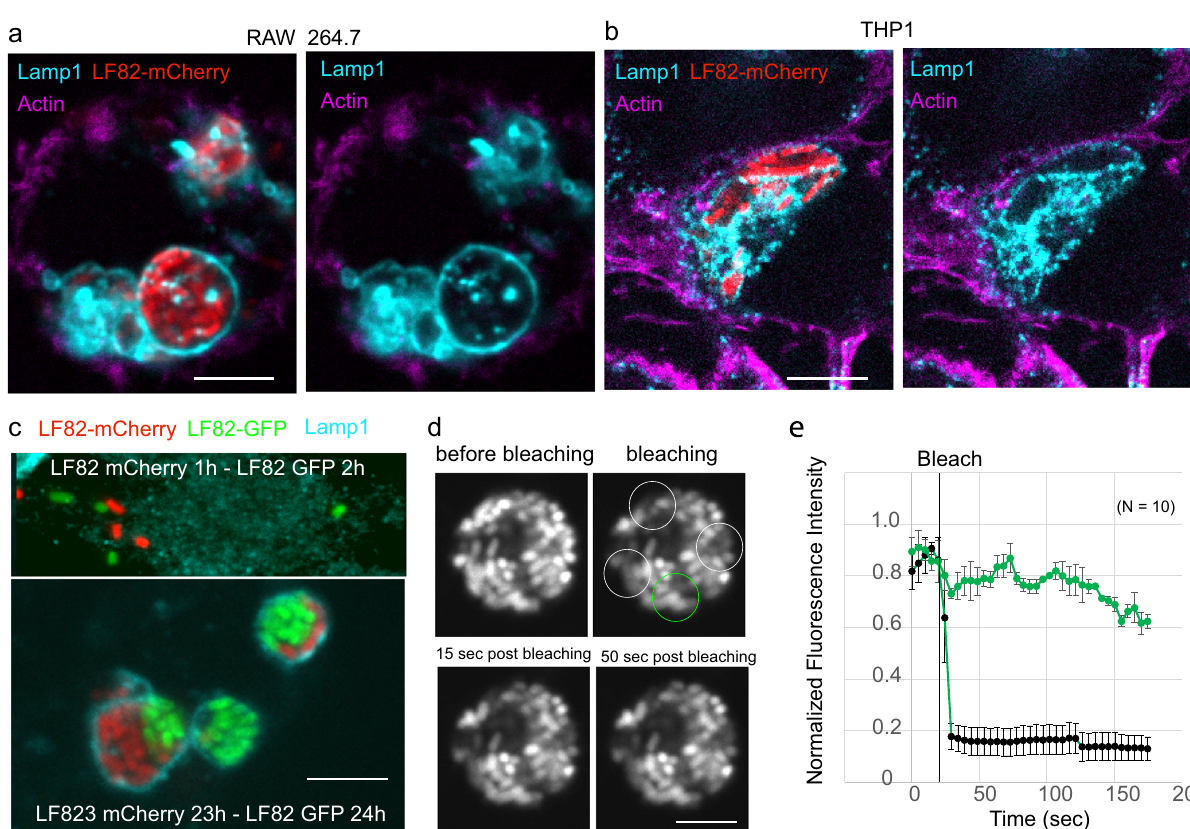
Fig. 1 Intracellular LF82 form intracellular bacterial communities inside phagolysosomes. a Imaging of the phagolysosomes (antibody for Lamp1, cyan) of Raw macrophages (actin labeling with phalloidin, magenta) infected by LF82-mCherry (red) at an MOI of 30 at 24 h of P.I. b ) Imaging of the phagolysosomes of THP1 macrophages infected by LF82-mCherry at an MOI of 30 at 24 h of P.I. c Coinfection experiment. Raw macrophages were infected fi rst with LF82-mCherry, treated with gentamycin for 1 h to remove free LF82-mCherry and subsequently infected with LF82-GFP. At 24 h of P.I., phagolysosomes were labeled with the Lamp1 antibody (cyan) and imaged. d FRAP experiments on phagolysosomes containing LF82-GFP at 24 h of P.I. White circles outline the bleached regions, and green circles outline the control region. The scale bars are 5 µ m. e Fluorescence quanti fi cation of the FRAP experiment presented in d . Data are average + / − SD of 10 FRAP and control